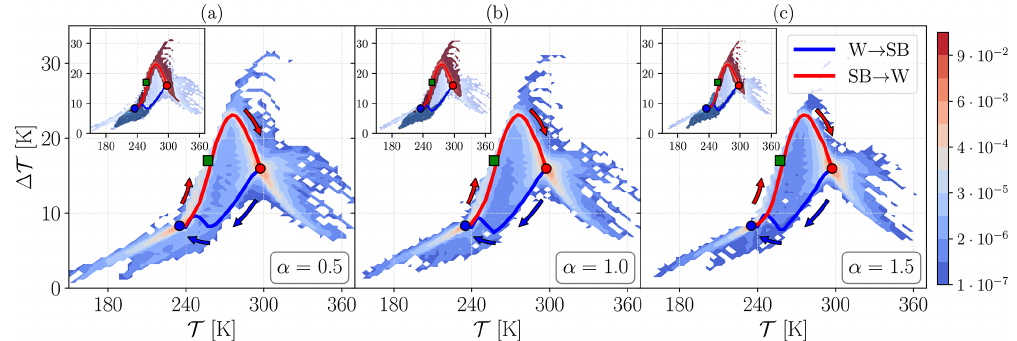
Figure 5. A two-dimensional projection of the invariant measure on (cid:0) T ,(cid:49) T (cid:1) for different choices of α for Lévy noise. (a) α = 0 . 5 and ε = 0 . 0001, (b) α = 1 and ε = 0 . 004, and (c) α = 1 . 5 and ε = 0 . 01. The blue (red) line corresponds to the W → SB ( SB → W ) most probable transition path, and the arrows show the direction of the transitions. The coloured points indicate the deterministic attractors of the SB (blue), M (green), and W (red) states. In the inset of the left top corner plot in panels (a–c) , the dark blue (red) contours are the ensembles of the transition paths between W → SB (SB →